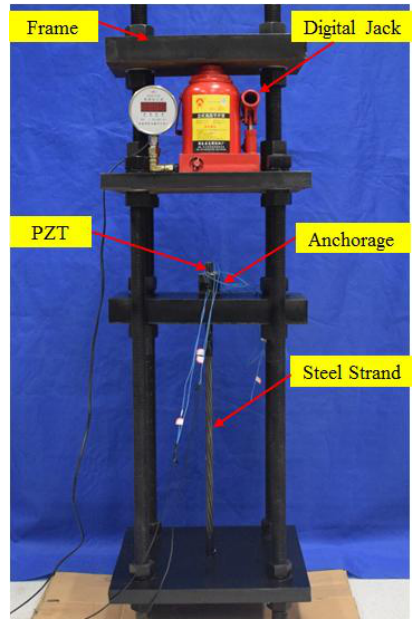
Figure 4. The test device.